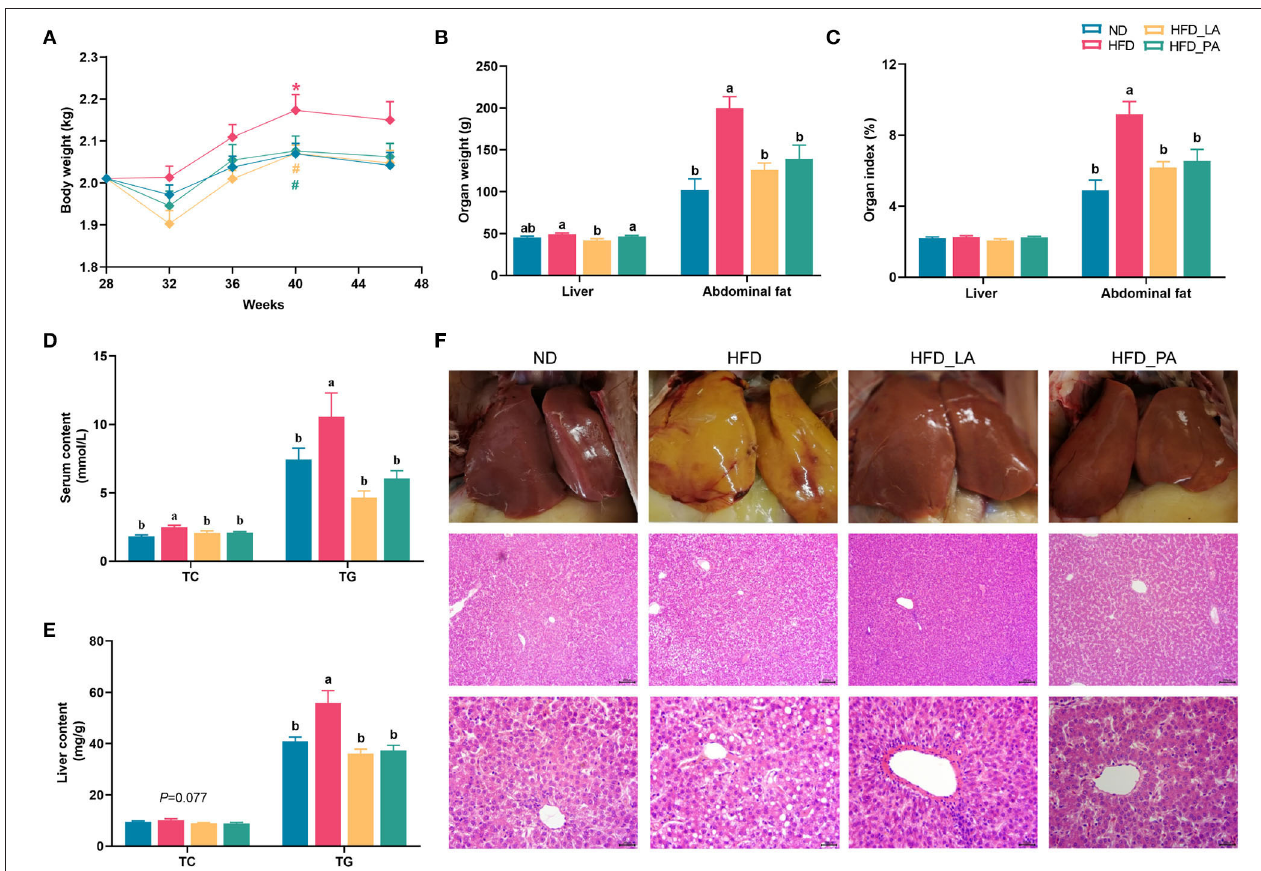
FIGURE 1 | Akkermansia muciniphila attenuated fatty liver hemorrhagic syndrome (FLHS) induced by a high-energy, low-protein diet (high-fat diet, HFD) in laying hens. (A) The body weight of laying hens ( n = 20). * p < 0.05, compared with the normal diet (ND) group. # p < 0.05, compared with the HFD group. (B) Liver and abdominal fat weight ( n = 10). (C) Liver and abdominal fat index ( n = 10). (D) Serum total cholesterol (TC) and triglyceride (TG) levels ( n = 10). (E) Hepatic TC and TG levels ( n = 10). (F) Examination of liver pathology using hematoxylin and eosin (H&E) staining. Different letters indicate significant differences at p <